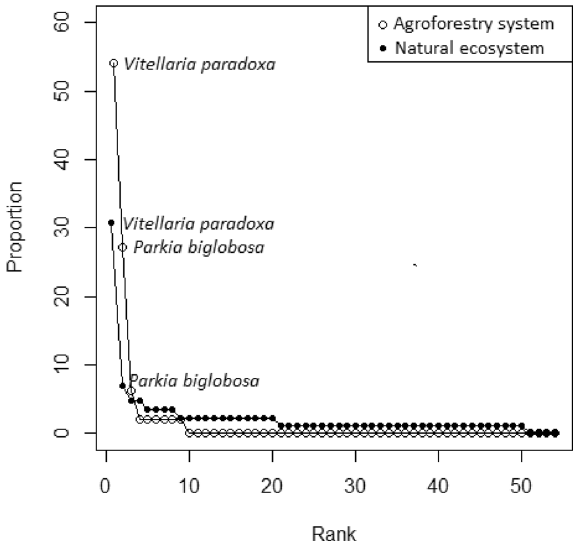
Figure 2. Rank-frequency diagrams of adjacent natural formations and traditional agroforestry systems of Pendjari Biosphere Reserve.